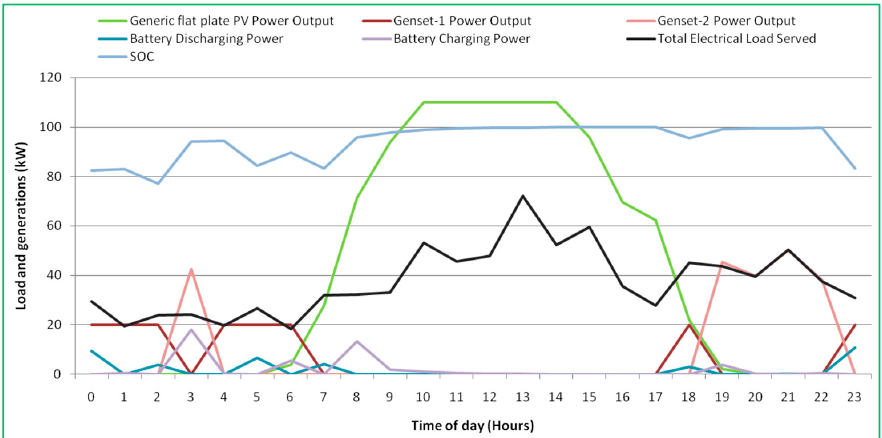
Figure 12. Sunny day without irrigation load for Case-2.